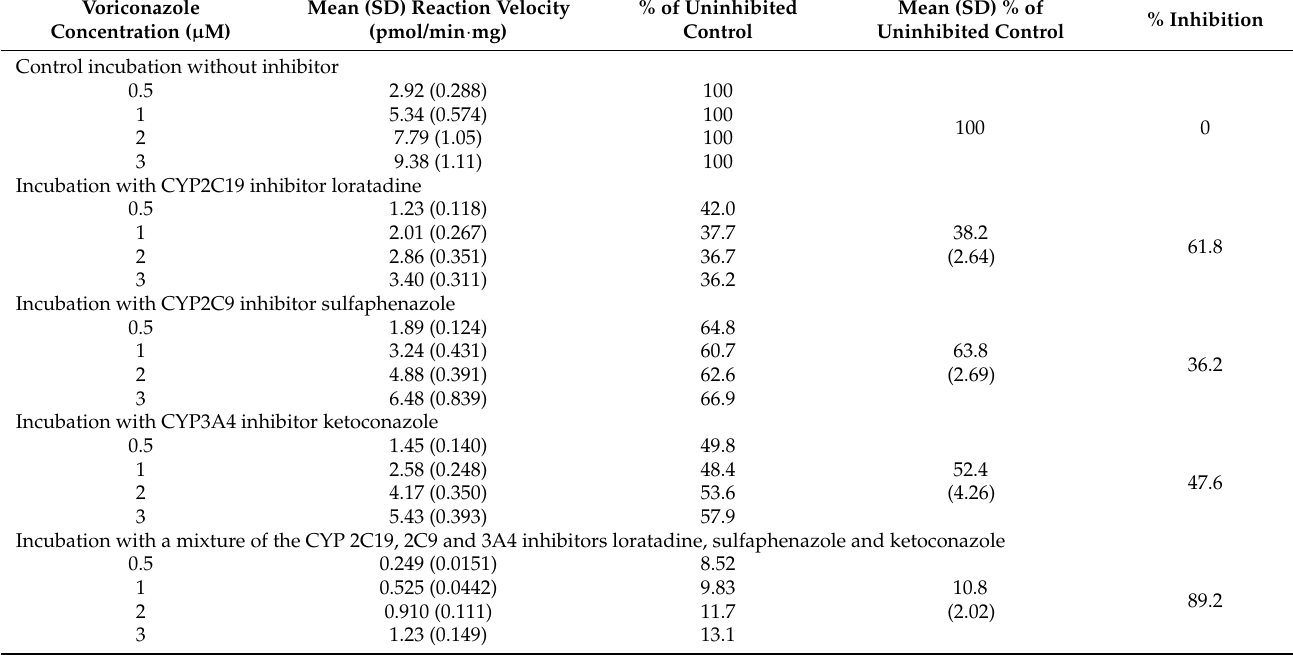
Table 2. Reaction velocities of voriconazole N -oxidation in the absence and presence of cytochrome P450 (CYP) enzyme inhibitors, their proportion compared to the uninhibited control incubation and the resulting percentage of inhibition ( n = 6). Voriconazole Mean (SD) Reaction Velocity % of Uninhibited Mean (SD) % of % Inhibition Concentration ( µ M) (pmol/min · mg) Control Uninhibited Control Control incubation without inhibitor